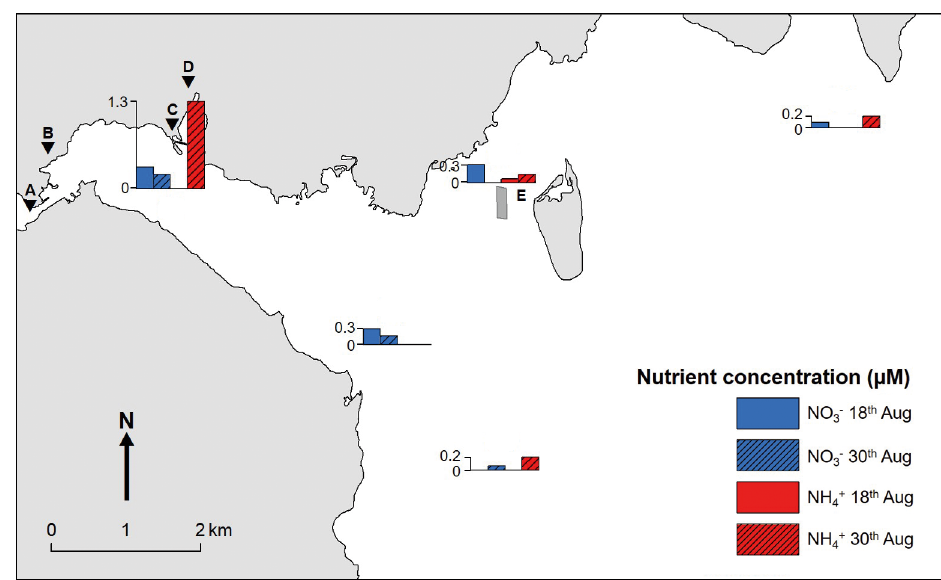
Fig. 2. NO 3− and NH 4+ concentrations of surface water samples collected at 2 different time periods. Chart position indicates sampling stations, and triangles indicate probable point sources (A: river mouth, B: sewage treatment facility, C: decommissioned pulp mill, D: biomass power plant). The grey box labelled E denotes the boundaries of the salmon farm